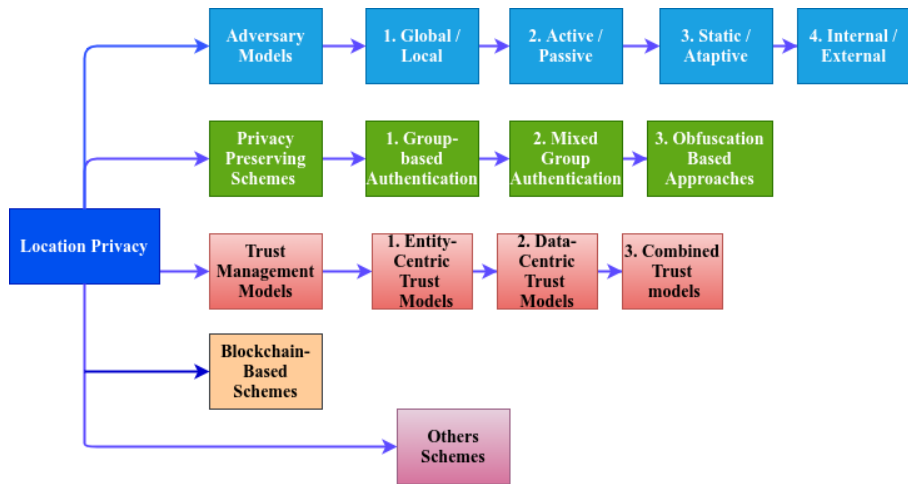
Figure 4. Privacy preserving schemes and trust management